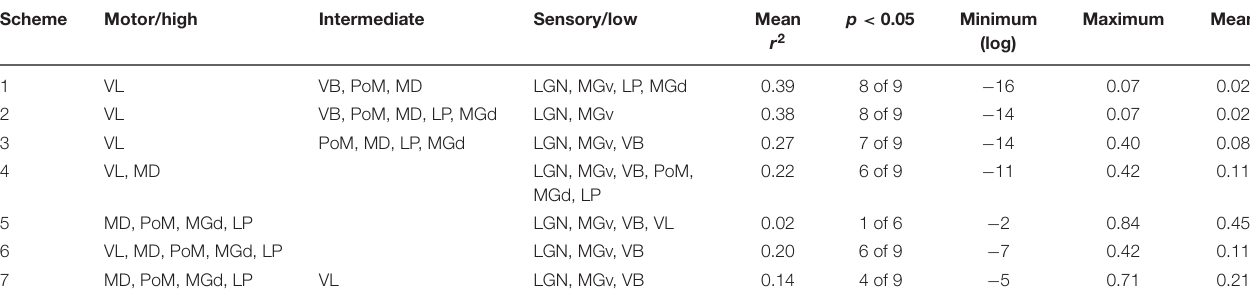
TABLE 3 | Classification of thalamic nuclei for correlation